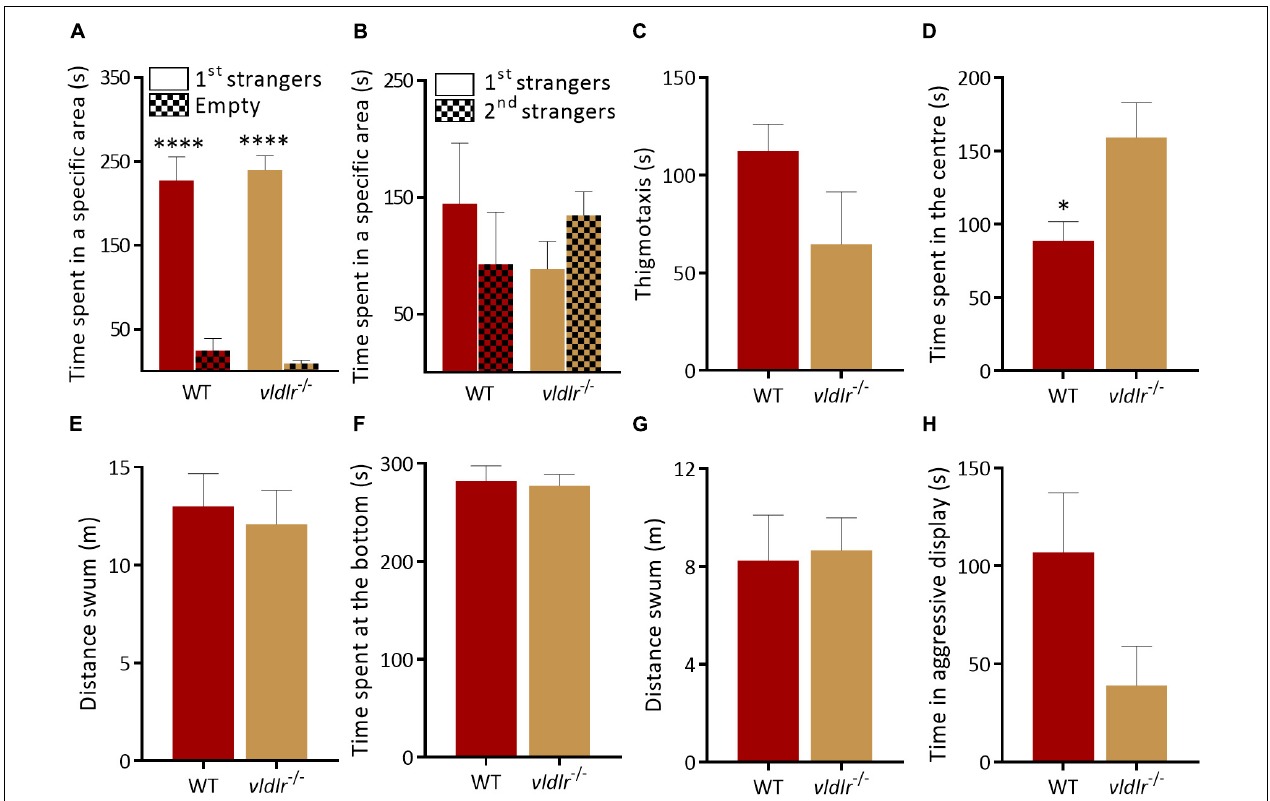
FIGURE 5 | Behavior of vldlr − / − zebrafish. (A,B) Social preference test. (A) Both genotypes prefer to spend time near a group of unfamiliar fish [1st strangers; p < 0.0001 for both genotypes; two-way ANOVA followed by Sidak’s post hoc , genotype factor: F (1,24) = 0.0039, p = 0.95, stranger factor: F (1,24) =